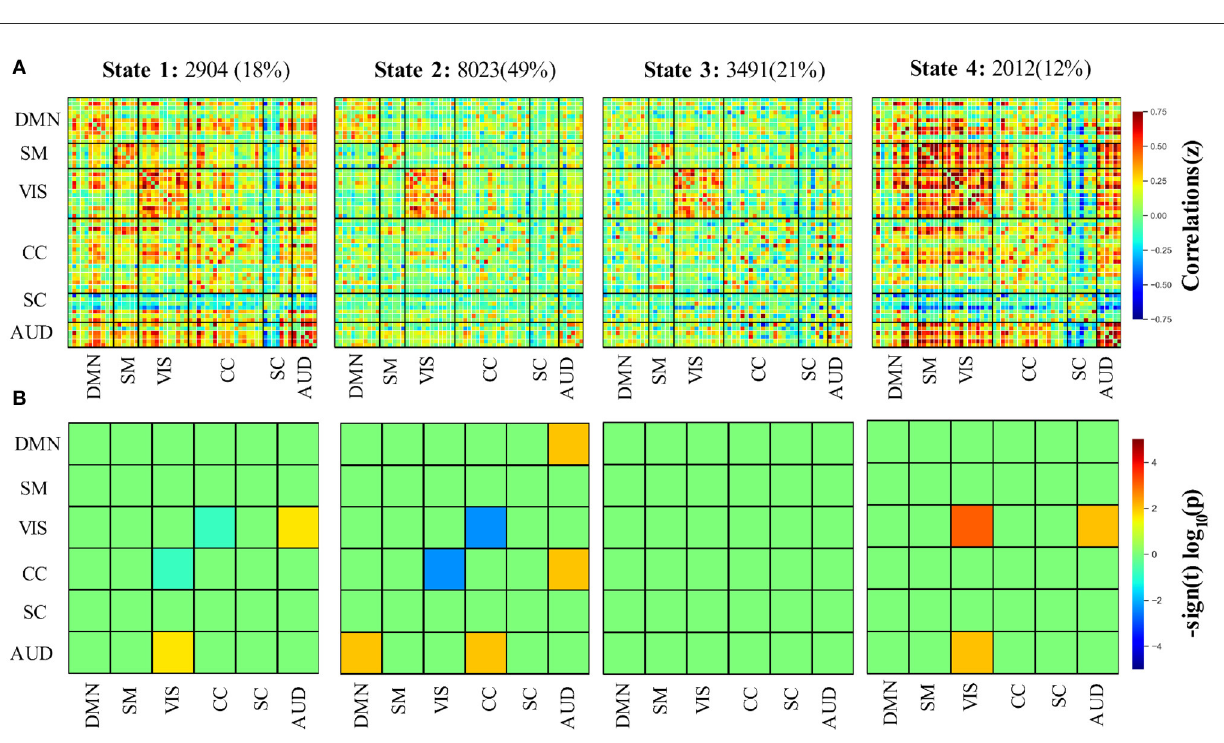
FIGURE4 (A) Four functional connectivity states as well as their frequencies across all participants using the group-ICA method. (B) Group differences of the 6 selected brain networks between elderly and younger adults in the 4 states. AUD, auditory domain; CC, cognitive control domain; DM, default mode domain; SC, subcortical; SM, sensorimotor domain; VIS, visual